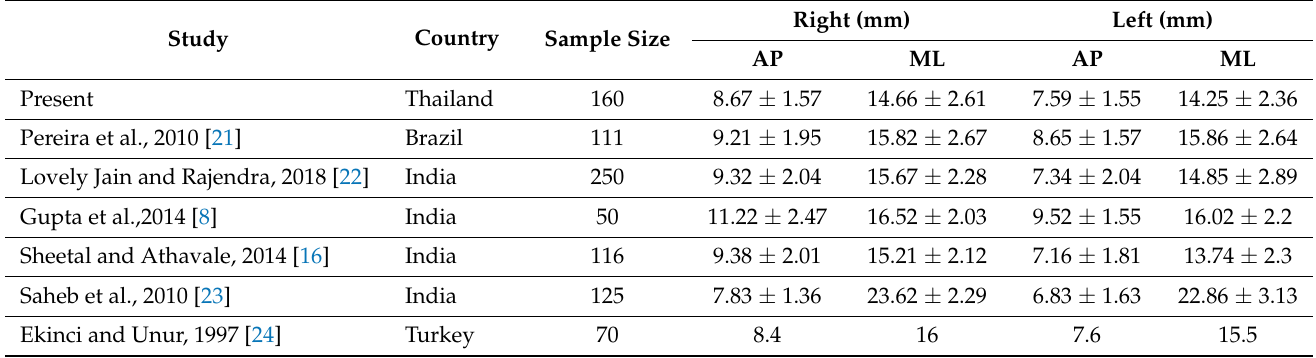
Table 5. Previous study morphometric study in the jugular foramen.